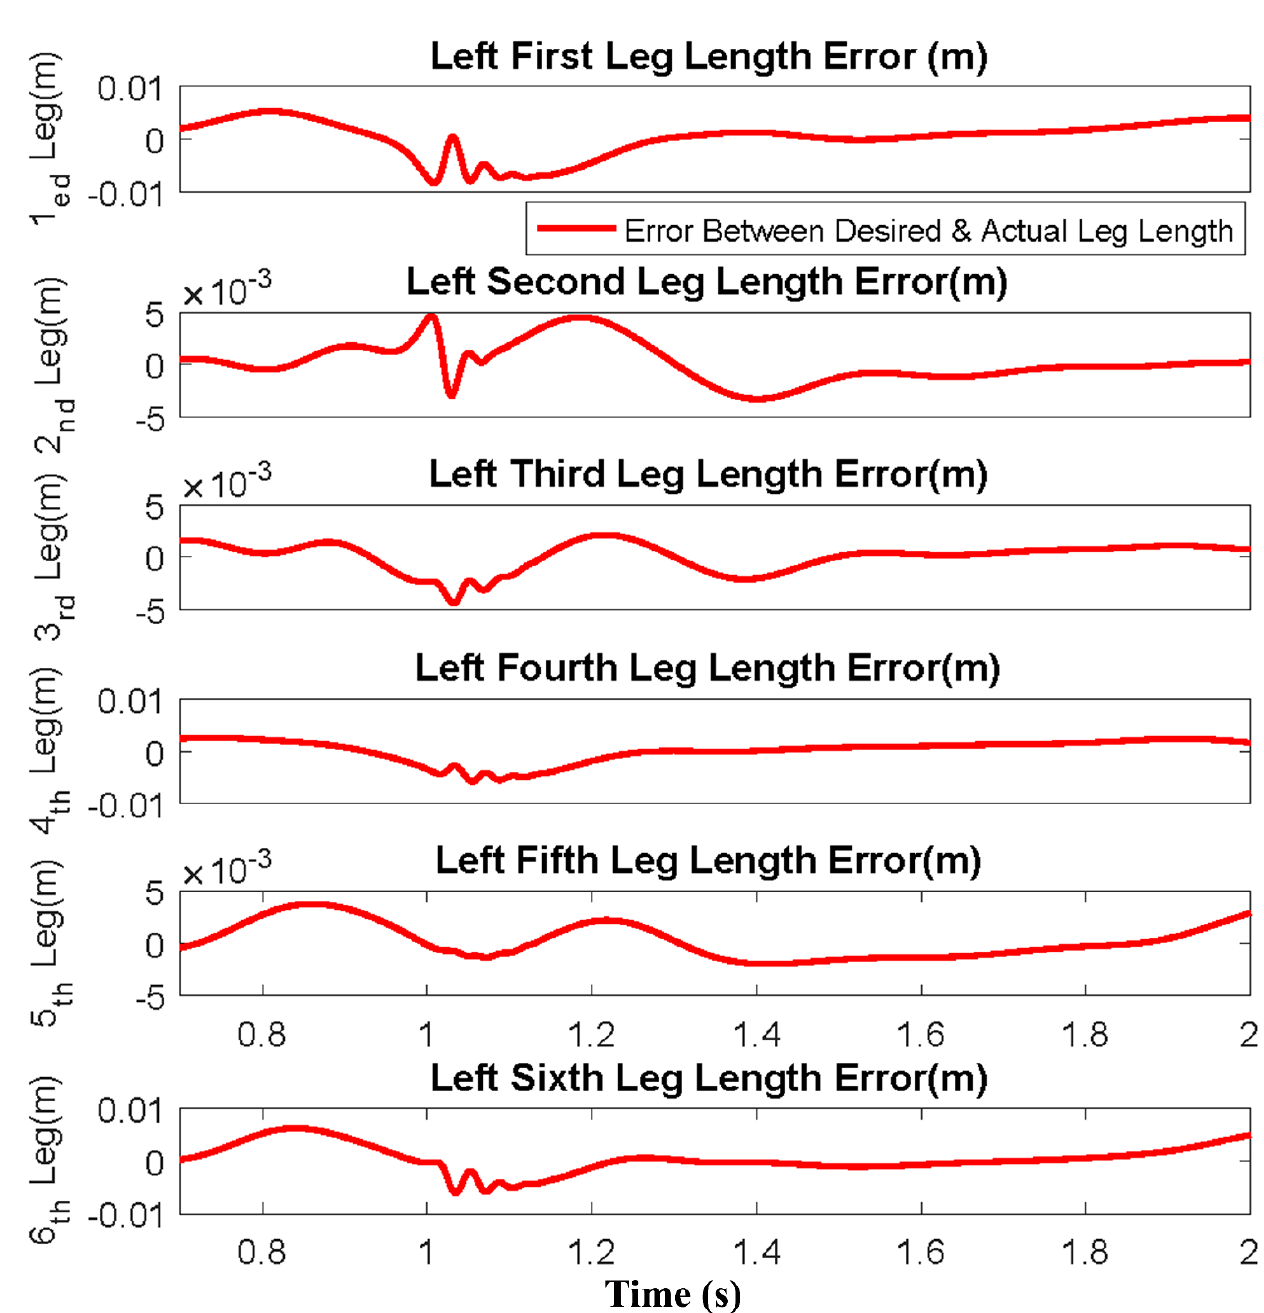
Figure 5. The errors between the desired and actual six legs of the left Stewart platform.